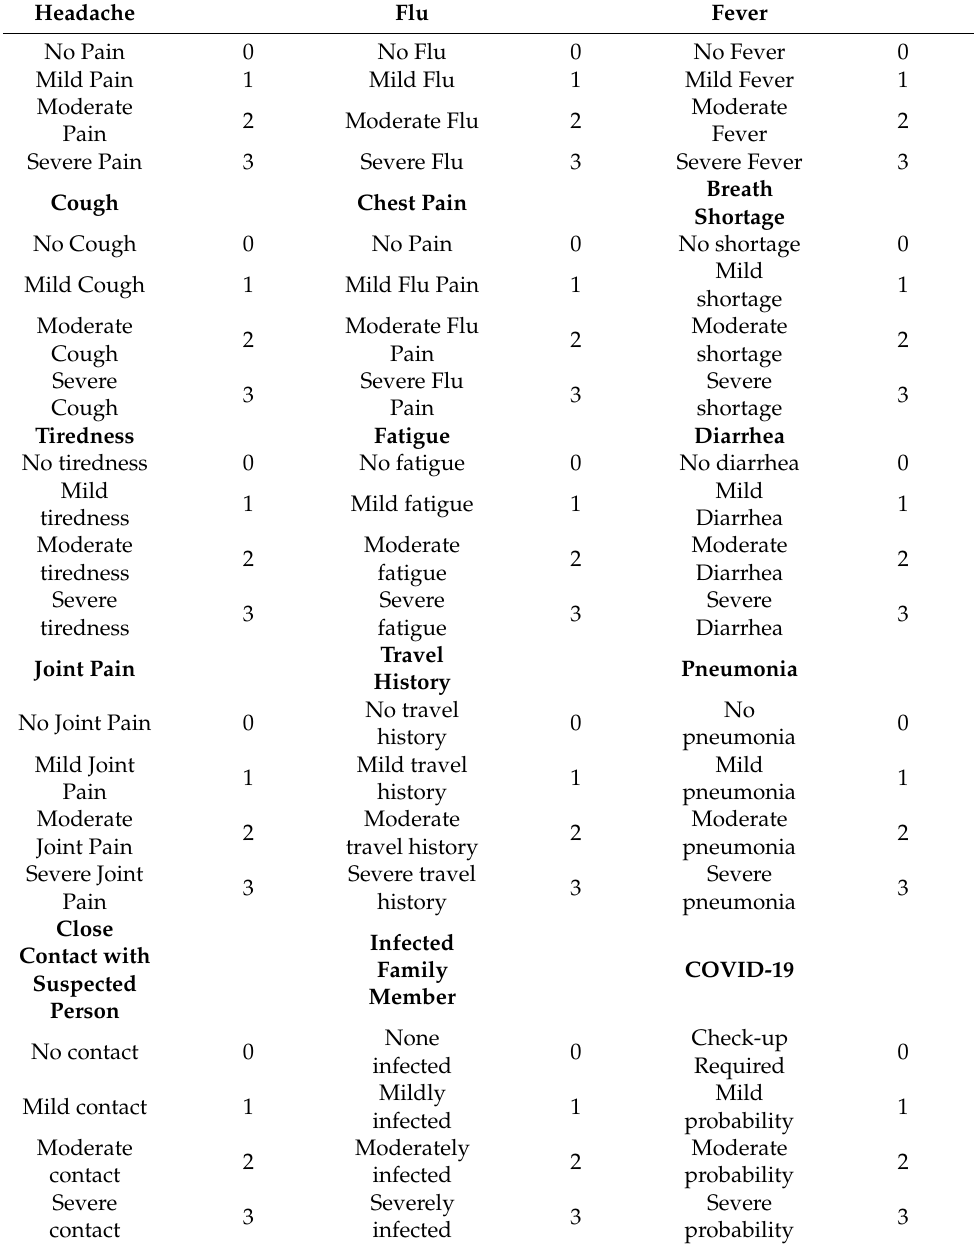
Table 1. Dataset Description on VRS-4